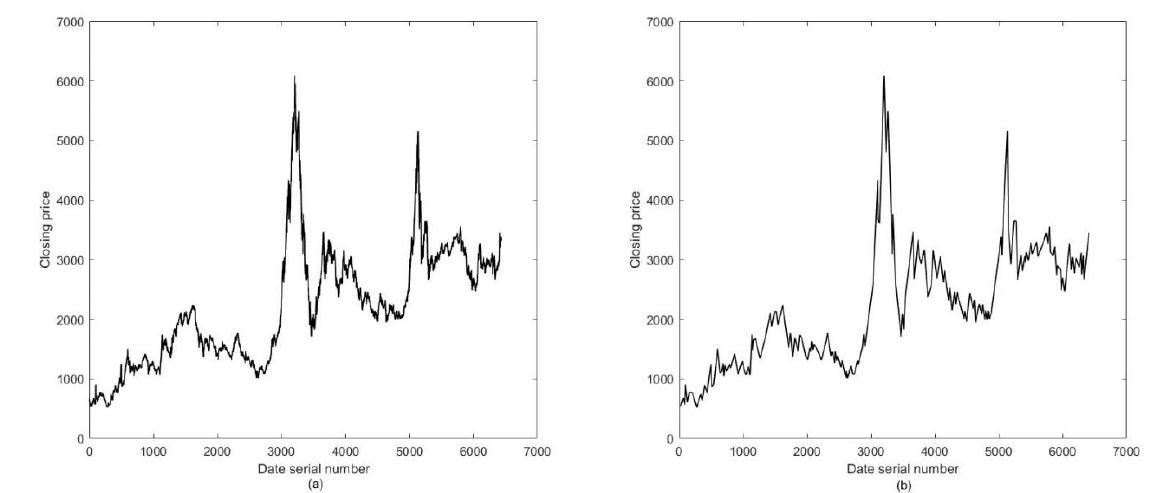
Figure 3. ( a ) Original index data by turning points of the Shanghai Index. ( b ) Fitted data by turning points of the Shanghai Index.